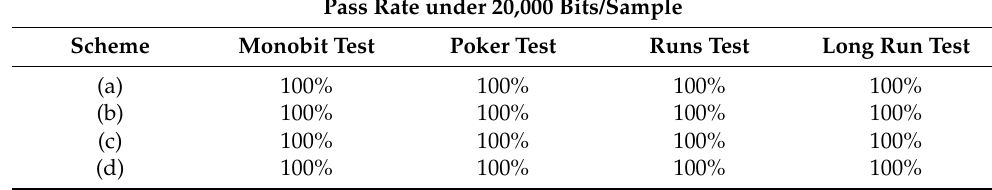
Table 3. Statistical test results of the proposed improved CML under FIPS PUB 140-1. (a) The improved CML based on logistic map; (b) the improved CML based on tent map; (c) the improved four stage compound CML, combining both logistic map and tent map in a single stage; (d) the improved four stage compound CML, combining logistic map and tent map in an alternate stage.